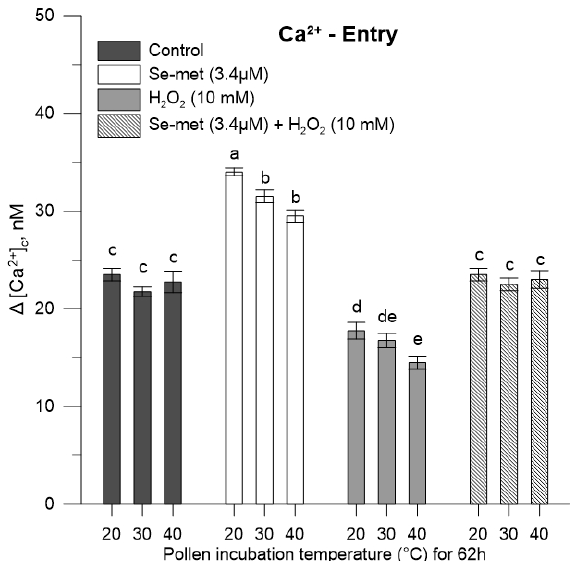
Figure 3. Ca 2+ -entry in olive pollen incubated at 20, 30, and 40 °C, in basal conditions (control), in the presence of Se-met (3.4 µM), H 2 O 2 (10 mM), and Se-met + H 2 O 2 and CaCl 2 1 mM in the incubation medium. Values are expressed as means ± SEM. Different letters indicate statistically significant differences ( p <